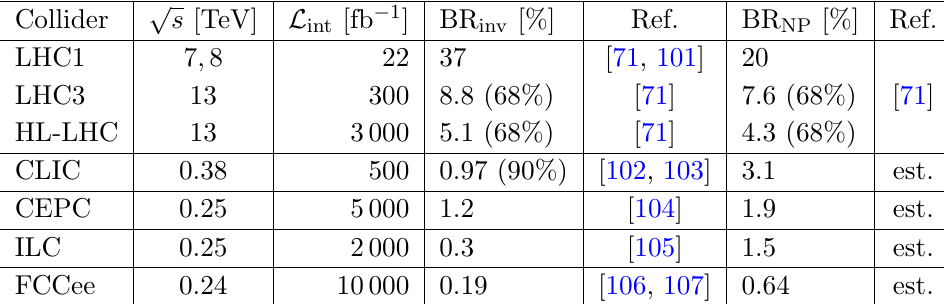
Table 1 . Current upper bound and projections on the branching ratios of h ! invisible and h ! NP at various colliders running at the given center-of-mass energies integrated luminosity L int . Unless states otherwise in parenthesis, the bounds are given at the 95% CL. The BR( h ! NP) at future lepton colliders is estimated via eq. (4.8) and the precision on (cid:20) Z given in the